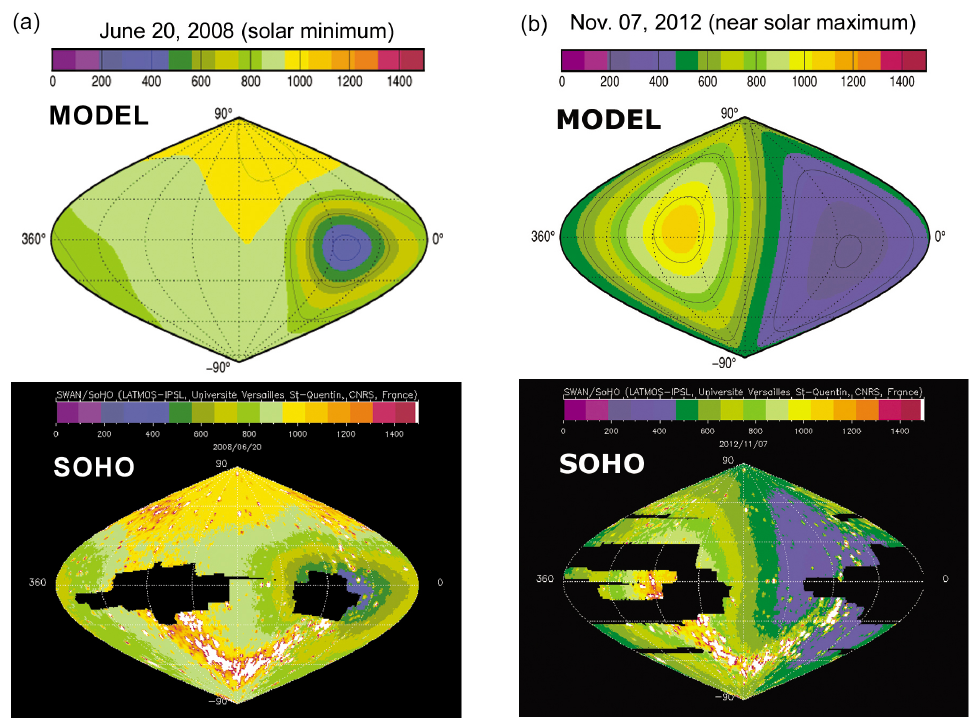
Figure 4. (a) Solar minimum all-sky maps for interplanetary Lyman- α background intensities [R] for 20 June 2008. Top: our simulated hot-model Lyman- α intensity map using A N = A S = 0 . 4, b e = 0 . 04, and b w = 11 . 5 ◦ . Bottom: observed Lyman- α all-sky intensities by SOHO/SWAN (provided via Web by LATMOS-IPSL, Université Versailles St-Quentin, CNRS, France: http://swan.projet.latmos.ipsl.fr/ images/). (b) Near-solar-maximum all-sky maps for interplanetary Lyman- α background intensities [R] for 7 November 2012. Top: our simulated hot-model Lyman- α intensity map using A N = A S = b e = 0. Bottom: observed Lyman- α all-sky intensities by